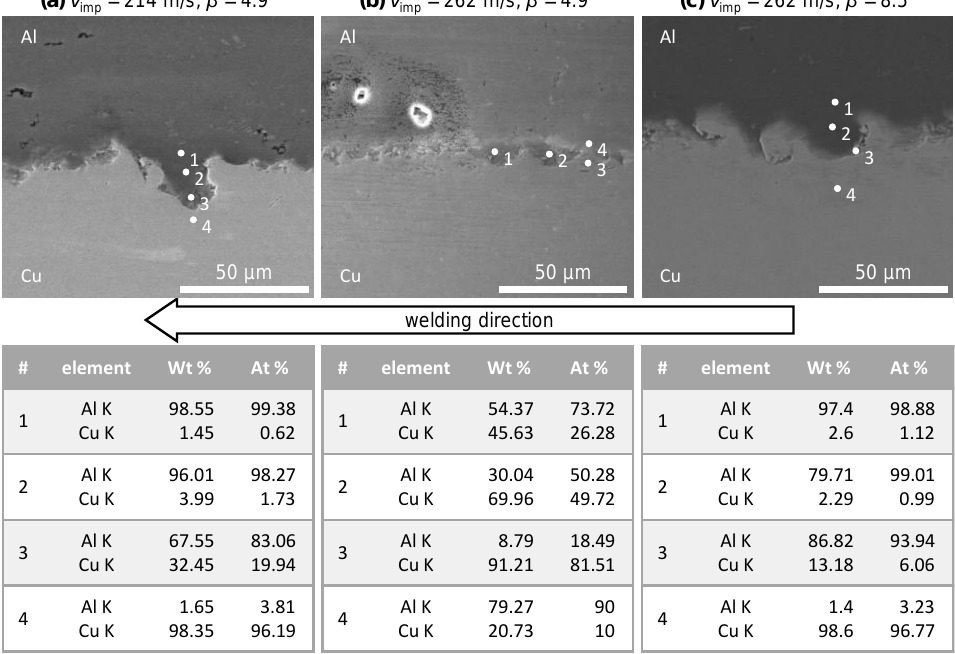
Figure 6. SEM images with EDX analysis at prominent locations of the cross-sections shown in Figure